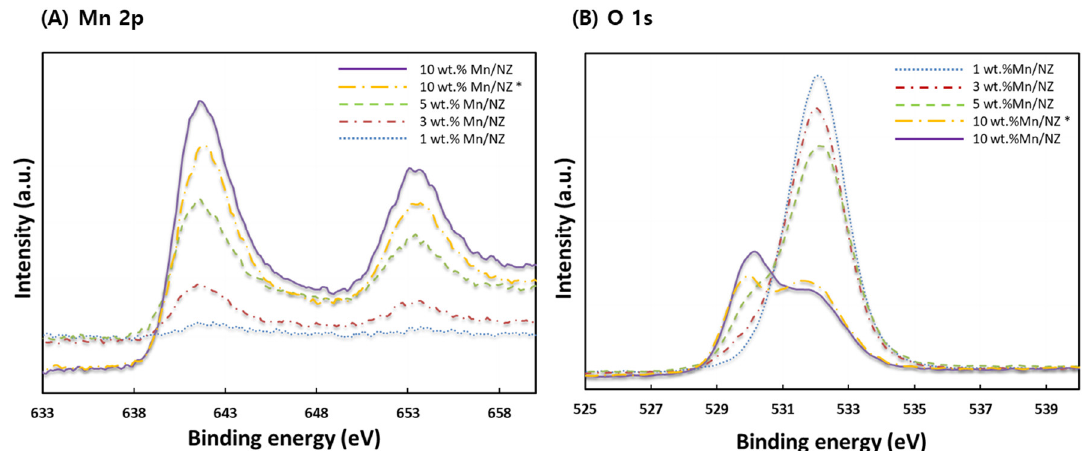
Figure 1. The Mn 2p and O 1s high resolved XPS spectra of 1, 3, 5 and 10 wt.% Mn/NZ (10 wt.% Mn/NZ *: without sonication).